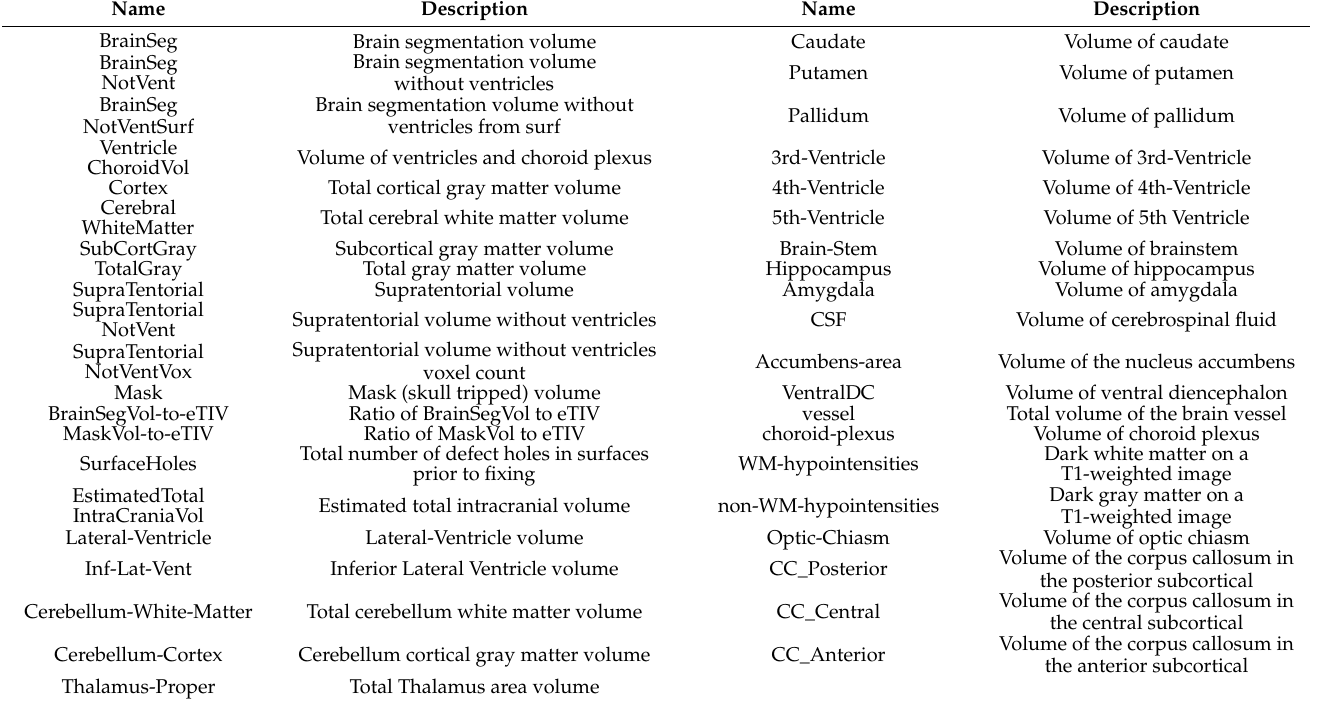
Table 2. Description of segmented parts of brain provided by